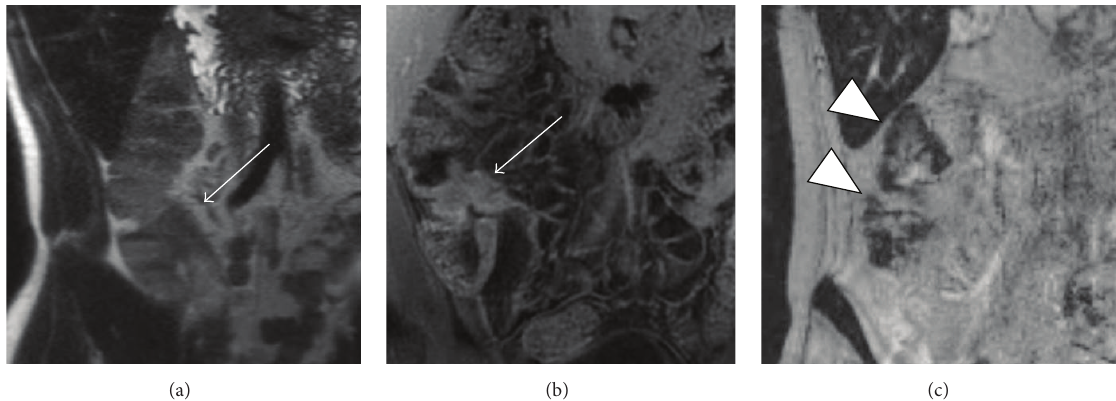
Figure 4: USPIO-enhanced MR imaging of the bowel in a patient with Crohn’s disease who received ferumoxytol infusion 24 hours earlier as iron replacement therapy. (a) Coronal T2-weighted and (b) coronal T1-weighted fat-saturated postgadolinium images demonstrating wall thickening and hyperenhancement of the terminal ileum (arrows). (c) Coronal T 2 ∗ -weighted image depicts nanoparticle accumulation in the wall of the cecum and ascending colon (low signal indicated by the arrowheads) indicating inflammatory involvement not visible on conventional MR sequences. Images courtesy of Mukesh Harisinghani, MD.